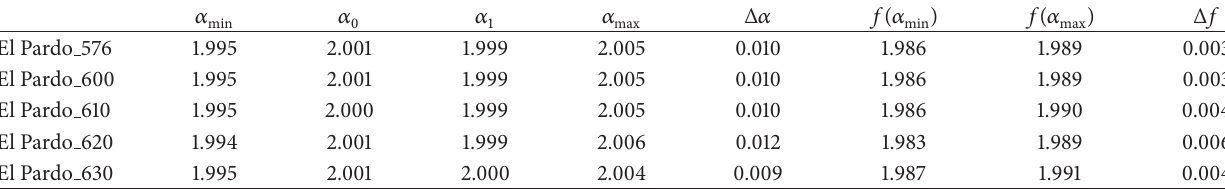
Table 1: Parameters extracted from the multifractal spectrum based on the original measure (altitude) with the water reservoir at different filling levels. Holder exponent at 𝑞 = −5 (𝛼 max ), 𝑞 = 0 ( 𝛼 0 ), 𝑞 = 1 ( 𝛼 1 ), 𝑞 = +5 ( 𝛼 min ), and 𝛼 max − 𝛼 min ( Δ𝛼 ). Multifractal value at 𝛼